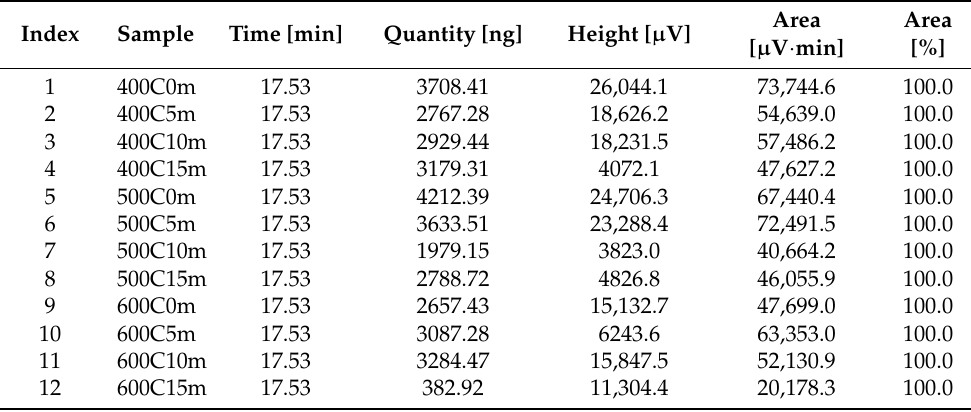
Table A1. Data of chromatogram (peak results).